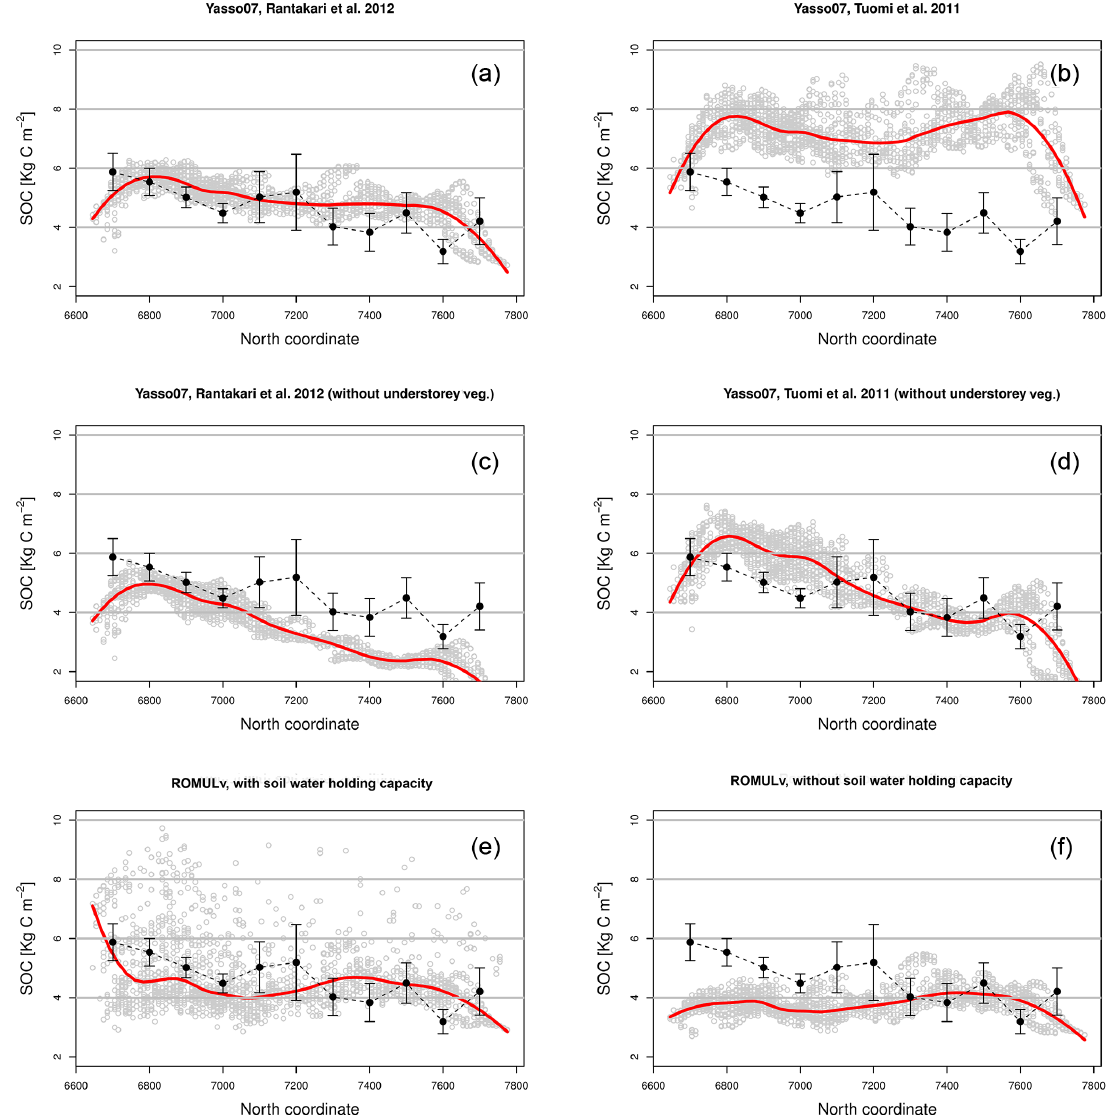
Figure 2. Latitudinal trends of measured and modelled soil carbon stocks across Finland. The x axis is the north coordinate according to Finnish YKJ system and y axis is the soil carbon stock Mgha − 1 . Grey dots are individual model estimates and the red line is a second-order LOESS fit. Panel (a) is Yasso07 with Rantakari et al. (2012) parameters, while panel (b) is with Tuomi et al. (2011) parameters. Panels (c) and (d) are same as panels (a) and (b) , but without understorey litter input. Panels (e) and (f) show the ROMULv model where (e) includes soil water holding capacity data and (f) includes constant soil water holding capacity. Black dots are means from Biosoil data for each latitude band and whiskers are 1.96 times the standard error of the